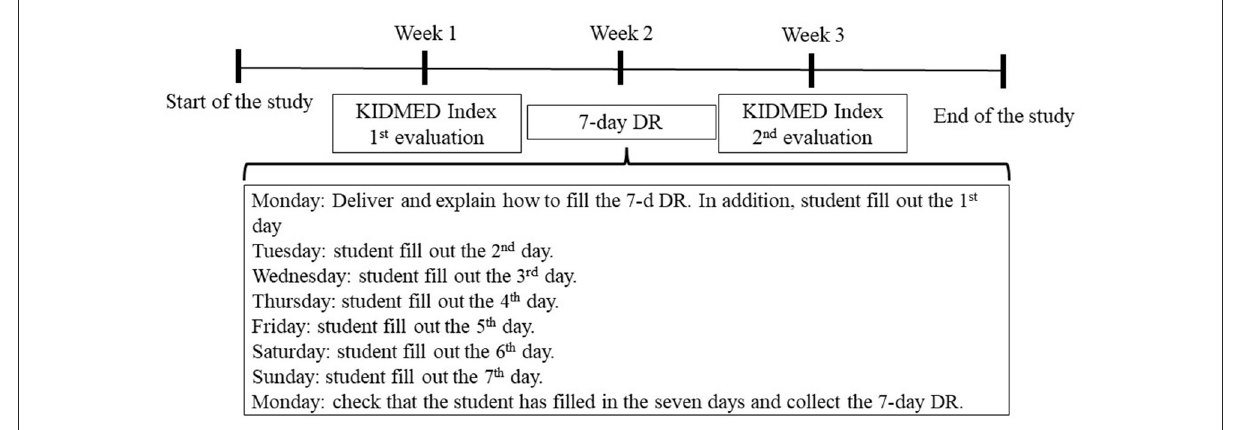
FIGURE1 Data gathering timeline. KIDMED Index; DR,